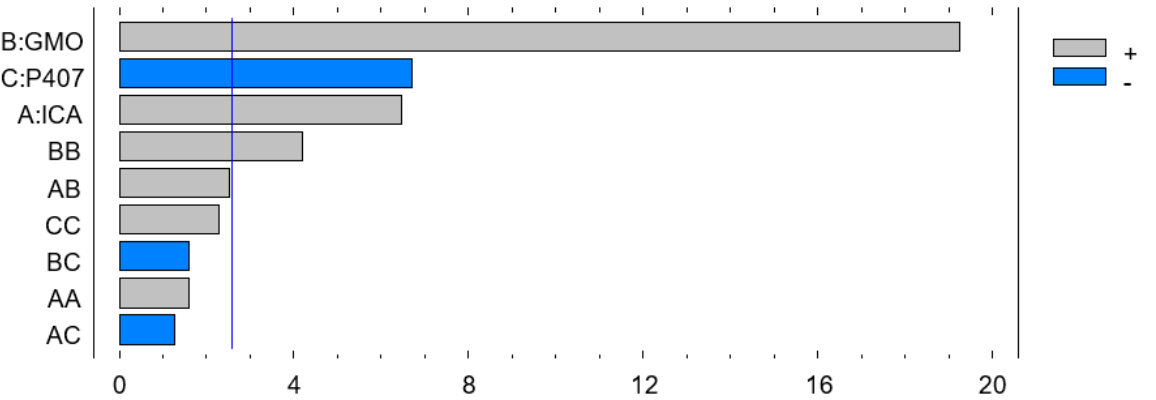
Figure 2. Pareto chart showing the effect of the ICA, GMO, and P407 concentrations on the particle size of the ICA-loaded cubosomes (ICA-Cubs) formulation.